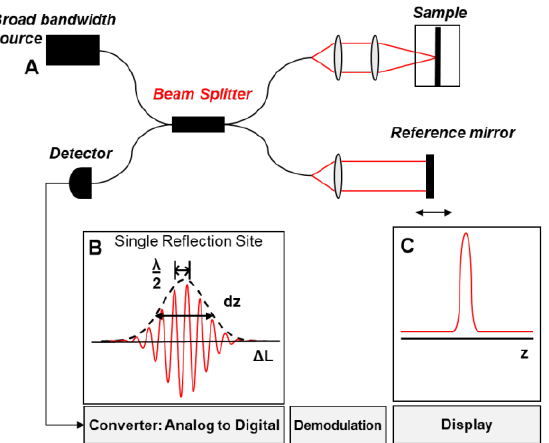
Figure 1. ( A ) Fiber-optic implementation of a time domain low coherence interferometer, ( B ) inter- ferogram, and ( C ) the A- Scan envelope. Where ΔL is the arm’s optical path length difference and dz ogram, and ( C ) the A-Scan envelope. Where ∆ L is the arm’s optical path length difference and dz the the coherence length. coherence